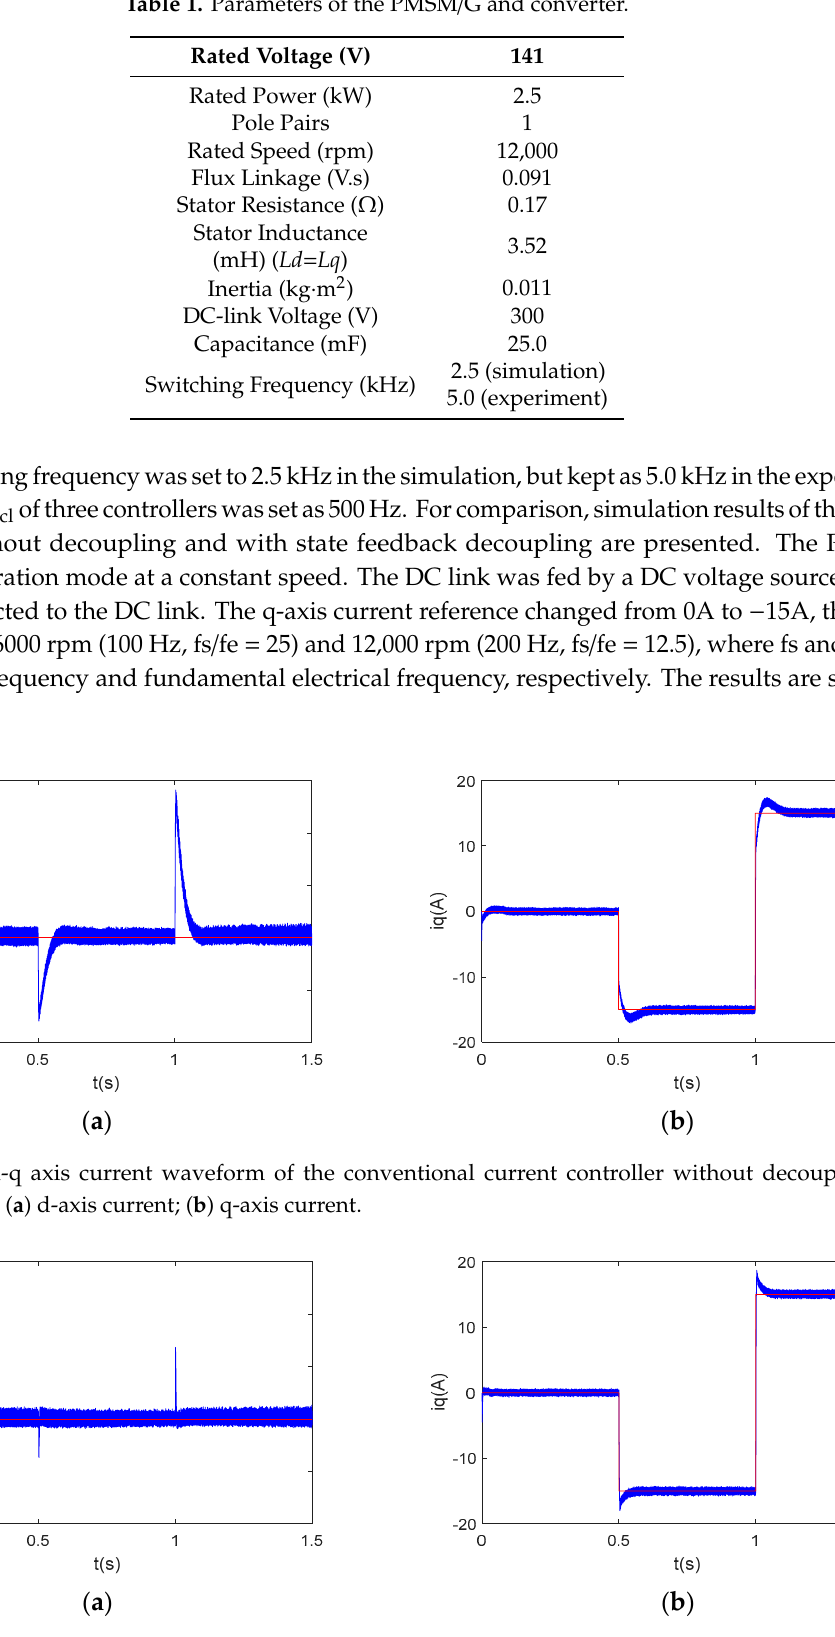
( b ) Figure 7. d-q axis current waveform of the proposed accurate discrete current controller at 6000 rpm. ( a ) d-axis current; ( b ) q-axis current. Figures 8–10 present the simulation results of the three current controllers at 12,000 rpm, where the advantage of the proposed accurate current controller was most significant. In Figure 8, a transient error − 12A occurred when the q-axis current changed from 0A to − 15A, whereas another 20A error occurred when the q-axis reference changed from − 15A to 15A. The recovery time was around 0.2 s. In Figure 9, the transient errors were reduced to − 10A and 15A, respectively, when the feedback decoupling was applied, with a recovery time of around 0.1 s. However, there is no obvious transient error present in Figure 10 when the q-axis current reference changed from 0A to − 15A, and a 5A error can be seen when the reference changed from − 15A to 15A. As for the q-axis currents, an